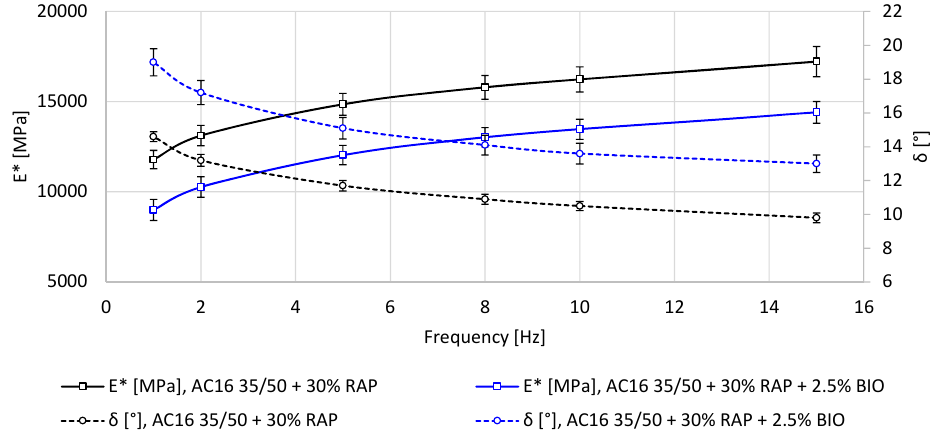
Figure 6. Complex modulus |E*| and phase angle | δ | in function of frequencies at 10 °C for asphalt mixtures.